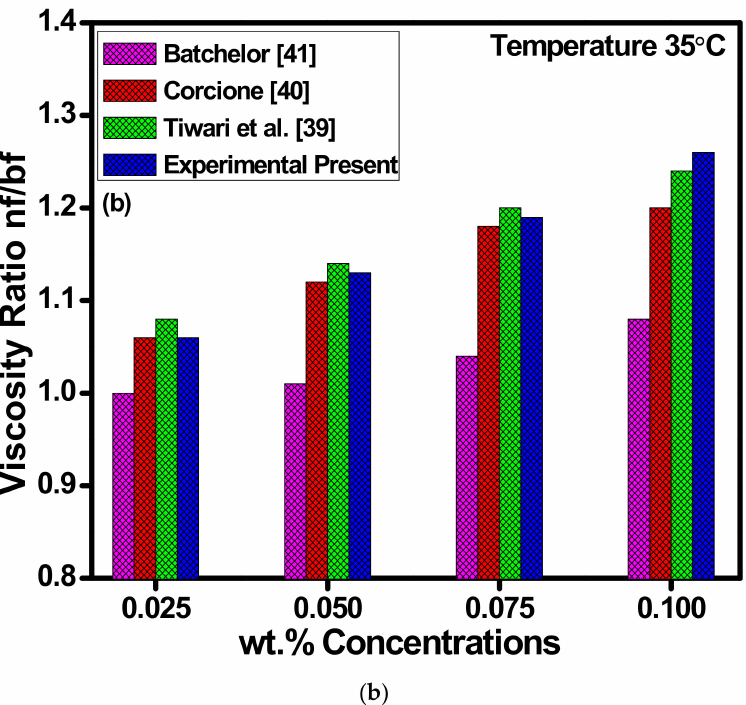
Figure 12. ( a ) Variations in thermal conductivities of ZnO-EG@DW-based nanofluids against tempera- ture at different wt.% of ZnO and ( b ) viscosity ratio for each of the concentrations at 35 ◦